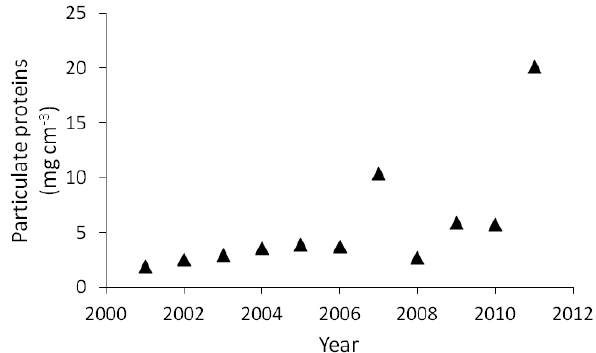
Fig. 8. Sediment-bound protein content cumulative over the top 5cm of sediment at HG I,